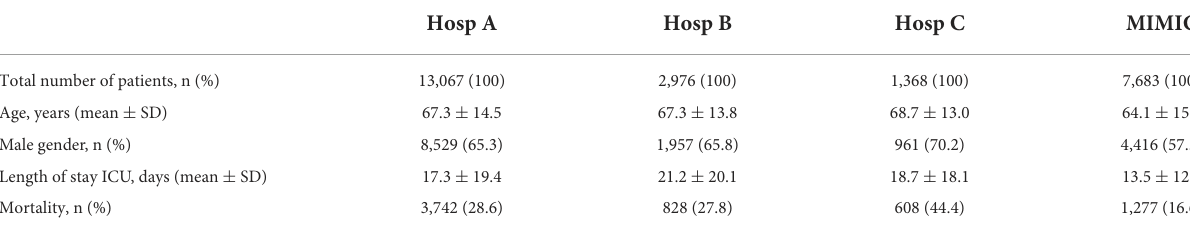
TABLE 1 Clinical characteristics of the analyzed patient cohorts in four hospitals under consideration.